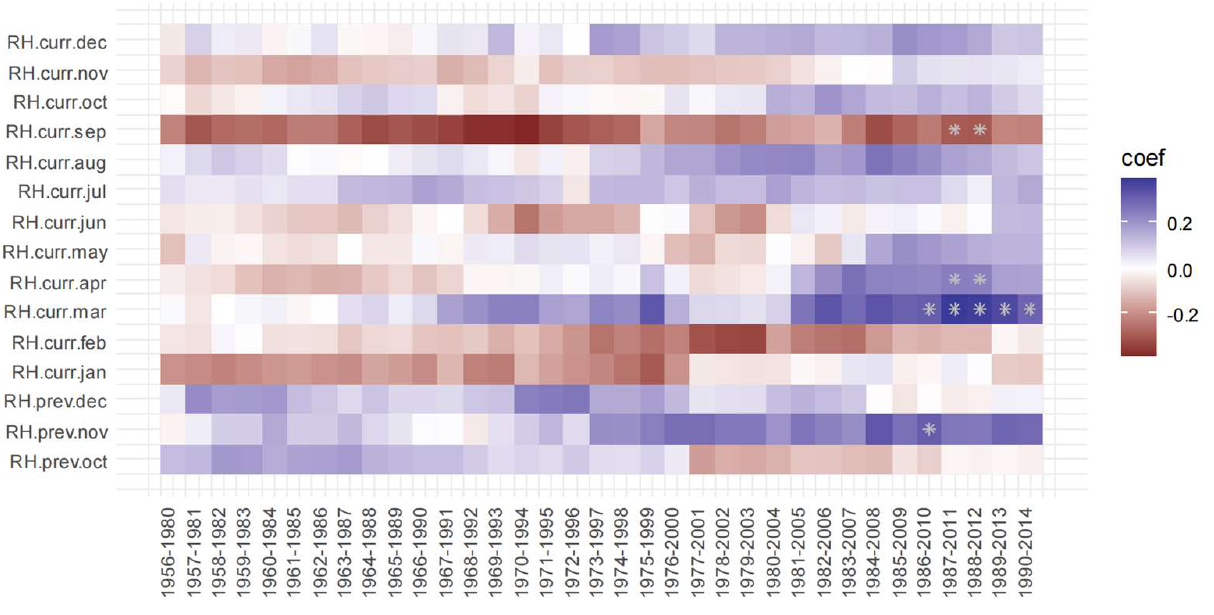
Figure 6. Moving correlation coefficients between tree-ring chronology and relative humidity; prev. and curr. indicate previous and current years; * indicates significance at the level of 0.05.